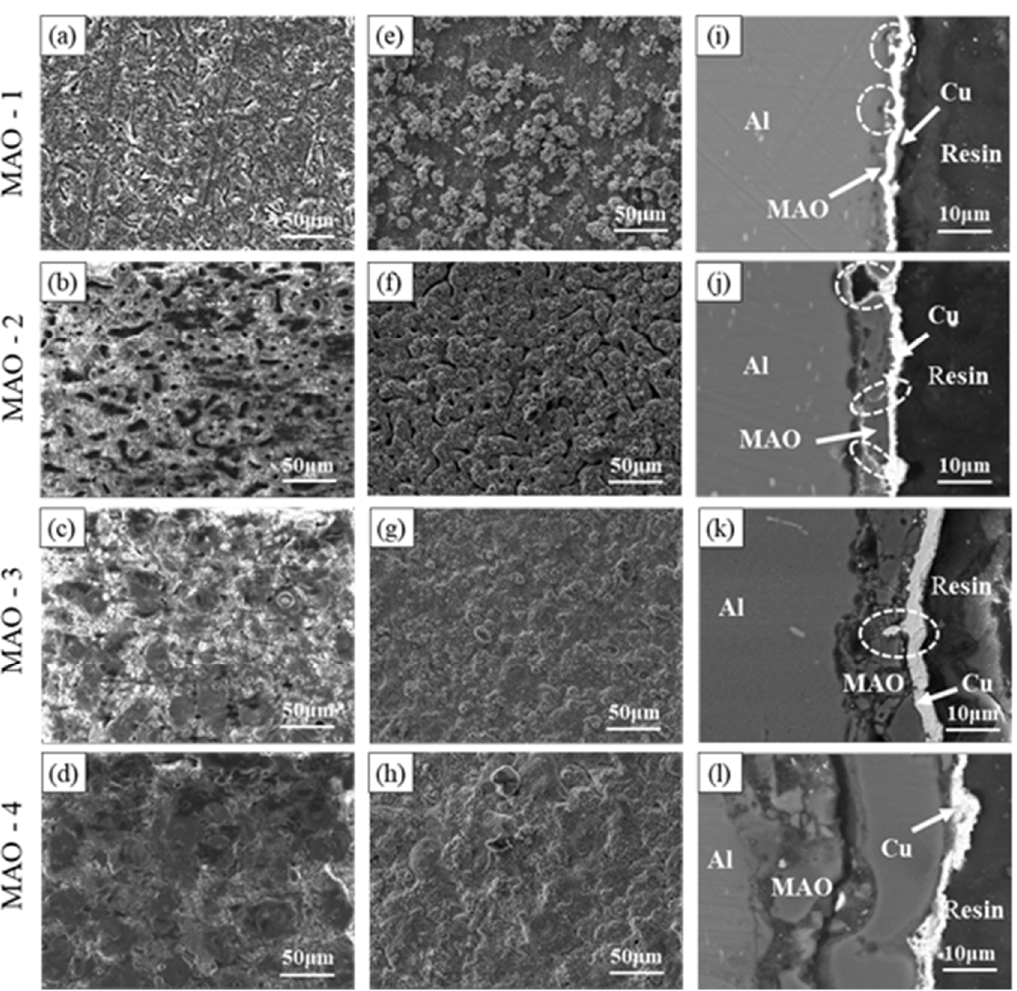
Figure 2. Surface morphology of MAO coating ( a – d ), surface morphology of MAO + Cu composite coating ( e – h ) and cross-section morphology of MAO + Cu composite coating ( i – l ). three-dimensional pictures are provided as Supplementary Figure S1.